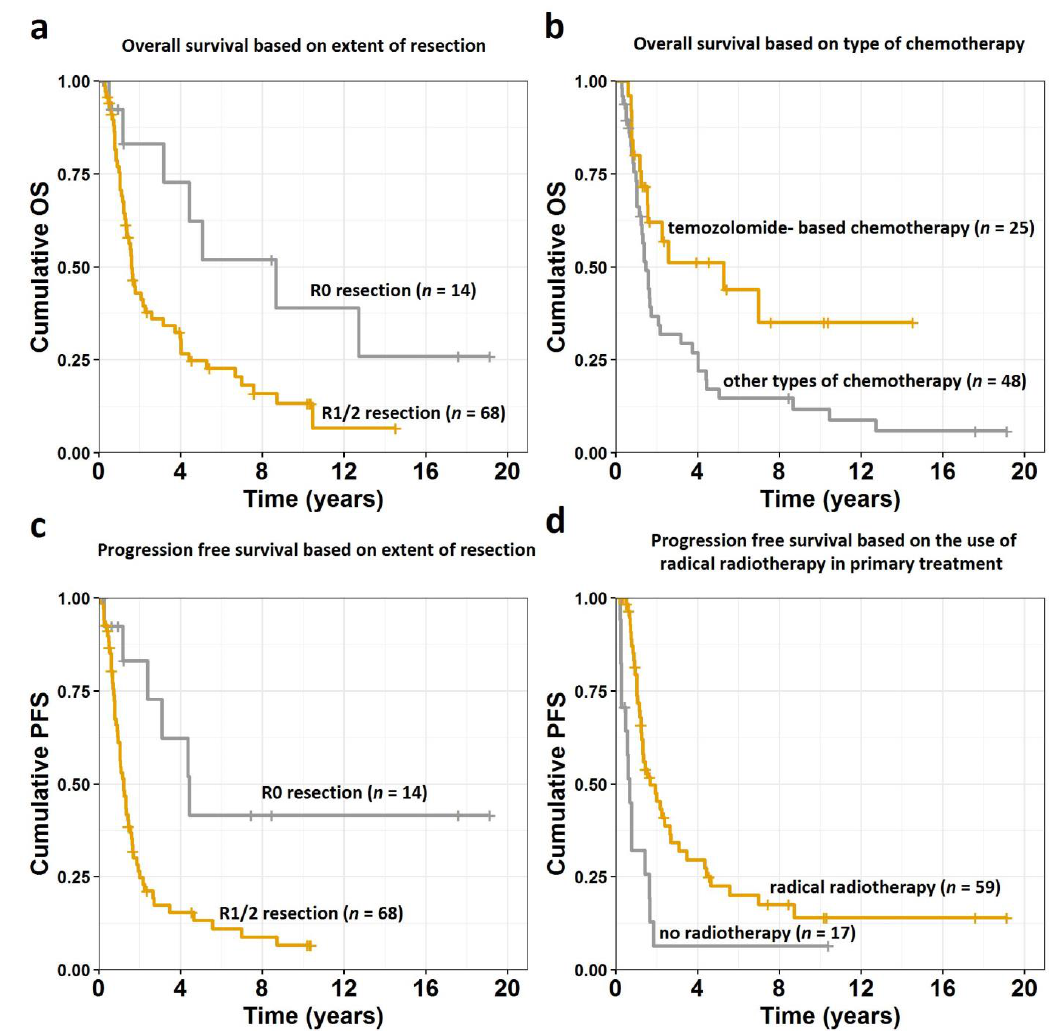
Figure 1. Overall survival curves for all analyzed patients divided into subgroups based on ( a ) extent of resection and ( b ) type of chemotherapy used in primary treatment and progression free survival for all analyzed patients divided into subgroups based on ( c ) extent of resection and ( d ) use of radical radiotherapy in primary treatment. Abbreviations: OS—overall survival; PFS—progression free survival; R0—radical resection (macro- and microscopically); R1—macroscopi- cally radical resection (but not microscopically); R2—macroscopically not-radical resection.